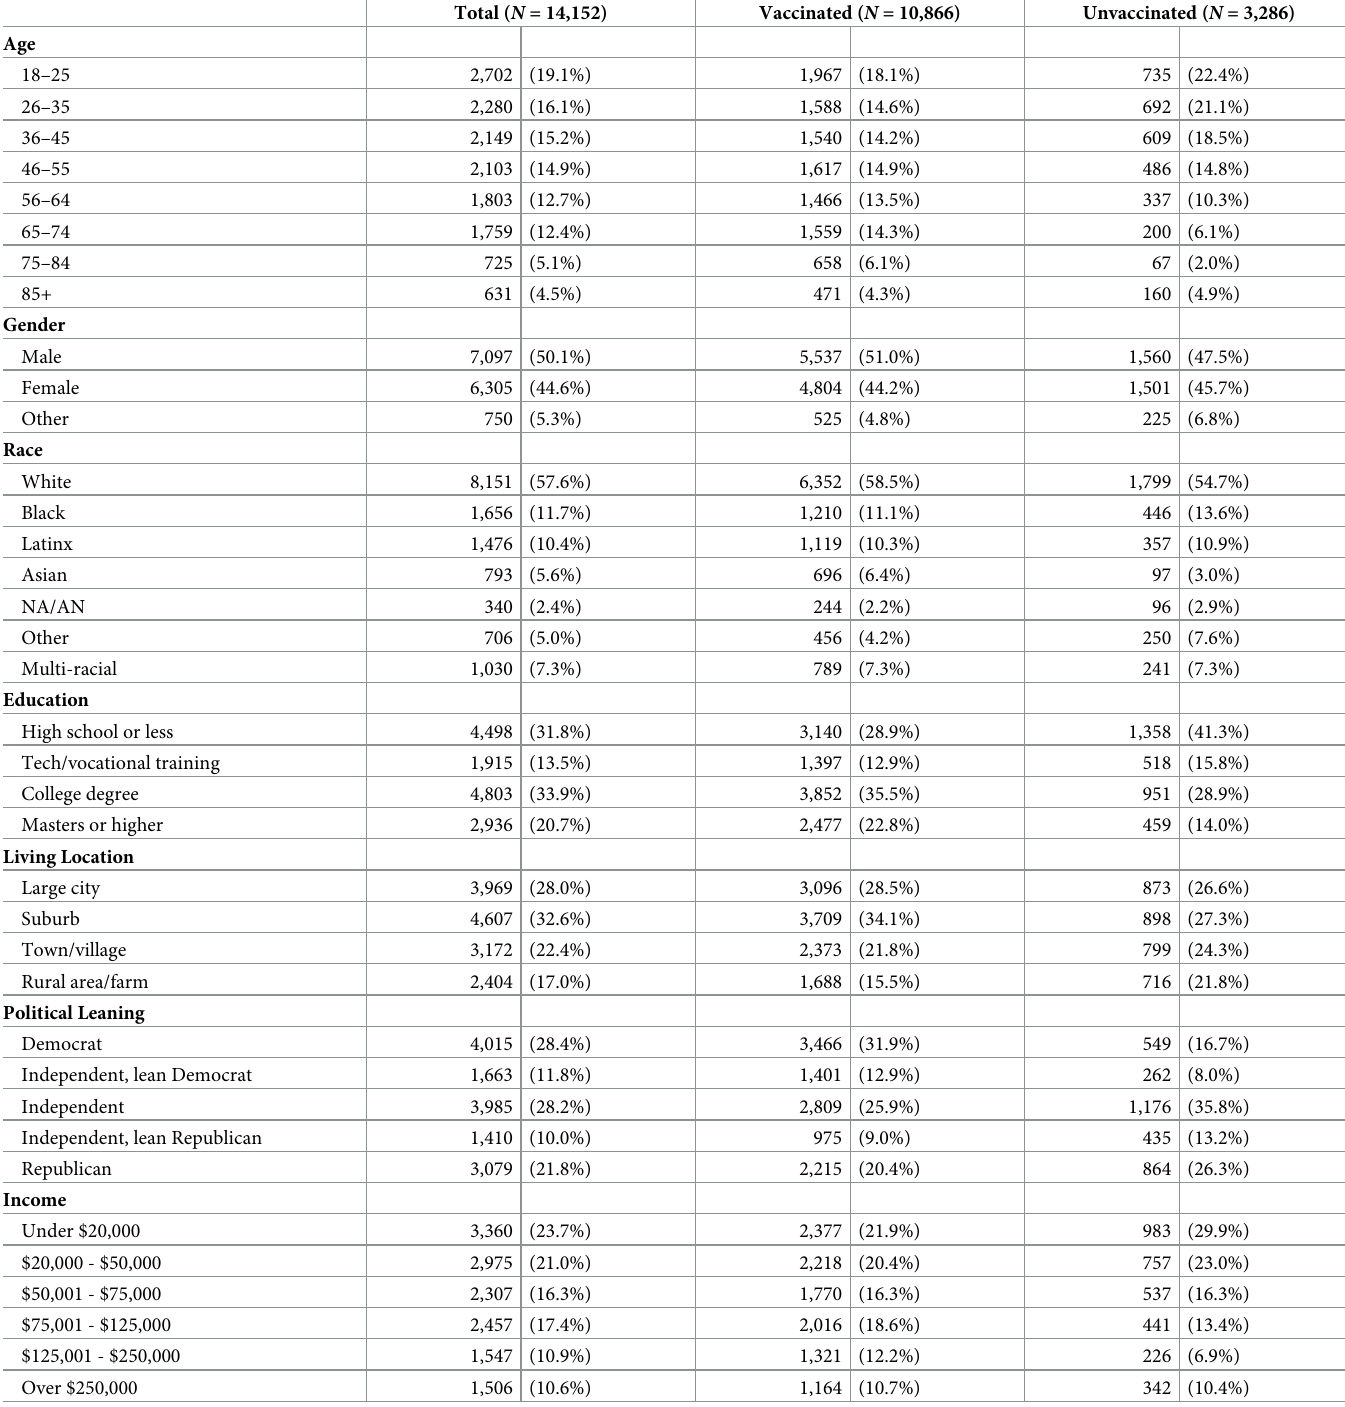
Table 1. Demographic characteristics of the full sample, vaccinated subsample, and unvaccinated